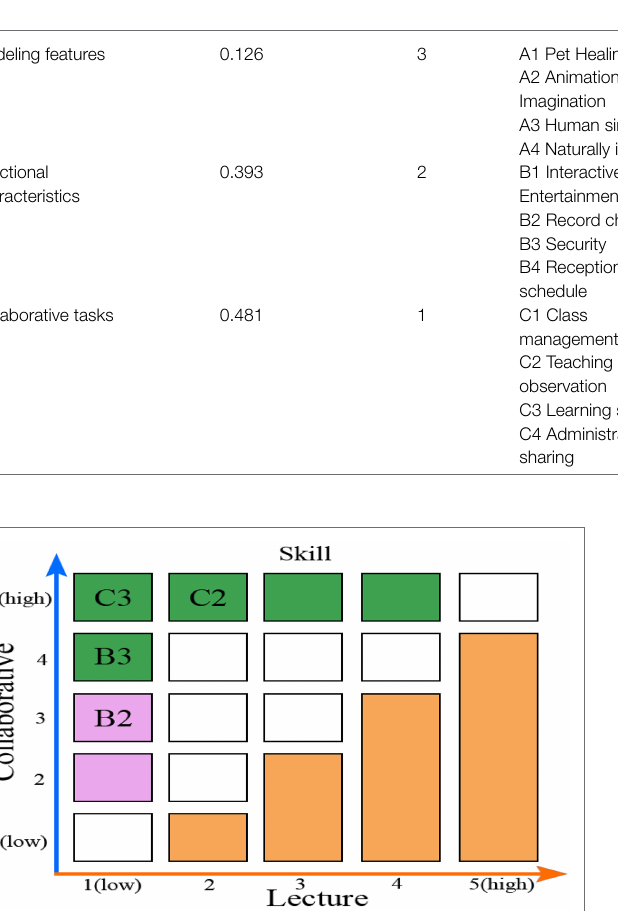
TABLE 4 | Overall weight analysis table and radar chart of factors affecting decisions about choice of AI technology by elementary school teachers. Facet